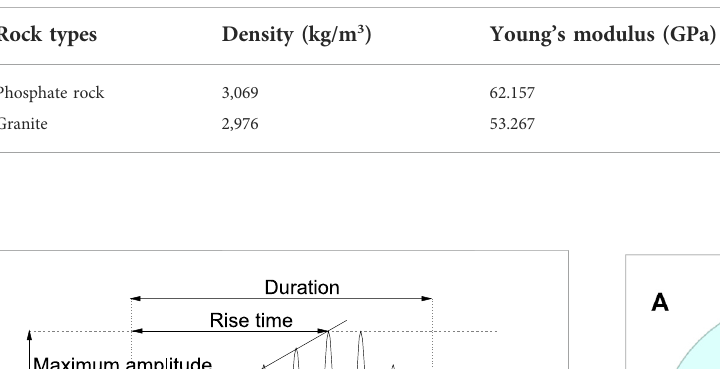
TABLE 1 Physical properties of the phosphate rock and grainte.